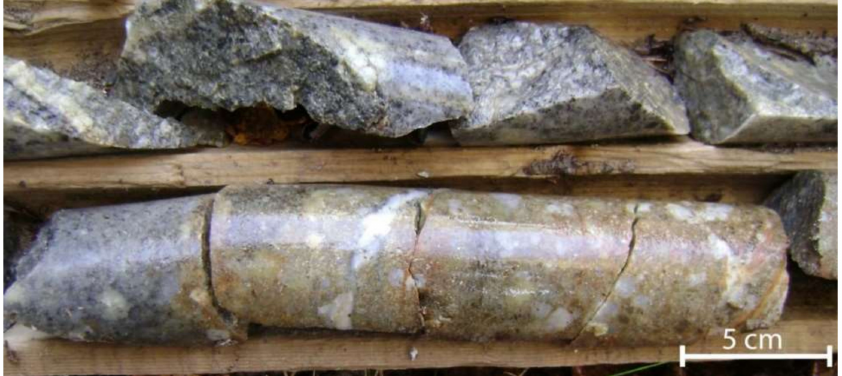
Figure 7. Photograph displaying a quartz vein (approximately 0.5 cm wide) cross-cutting an altered granodiorite (LG-80-33-1848). The diameter of the drill core is approximately 5 cm.